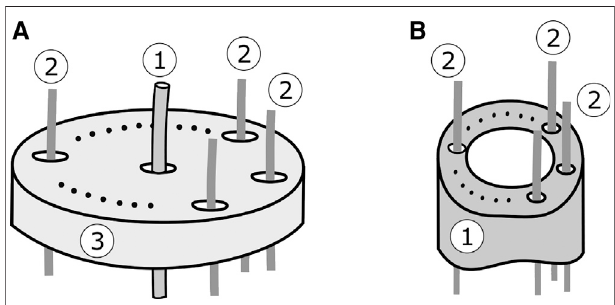
FIGURE3| SchematicsofthetwotypicalTDCRdesignstructures: (A) A primary fl exible, slender backbone (1) is employed, while equally distributed spacerdisks(3)areusedtoroutetendonsalongthebackbone(2); (B) Alarger diameter fl exible backbone (1) is used that already features inner lumens to guide the tendons (2) without the need of additional spacer disks.